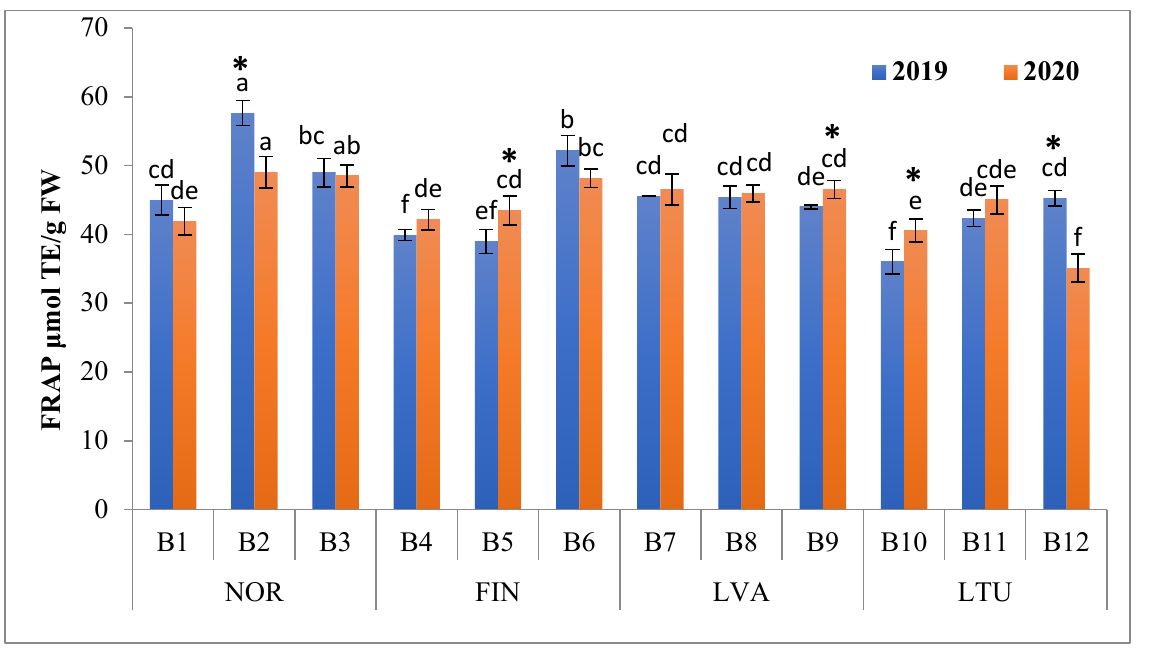
Figure 5. Ferric-reducing antioxidant power (FRAP) of bilberries ( µ mol TE/g FW). Different letters above the same color bars indicate significant differences between the mean values ( p < 0.05). Signifi- cant differences between 2019 and 2020 are indicated by asterisks (*) ( p < 0.05). Locations of bilberry samples collection include Norway (NOR), Finland (FIN), Latvia (LVA) and Lithuania (LTU).